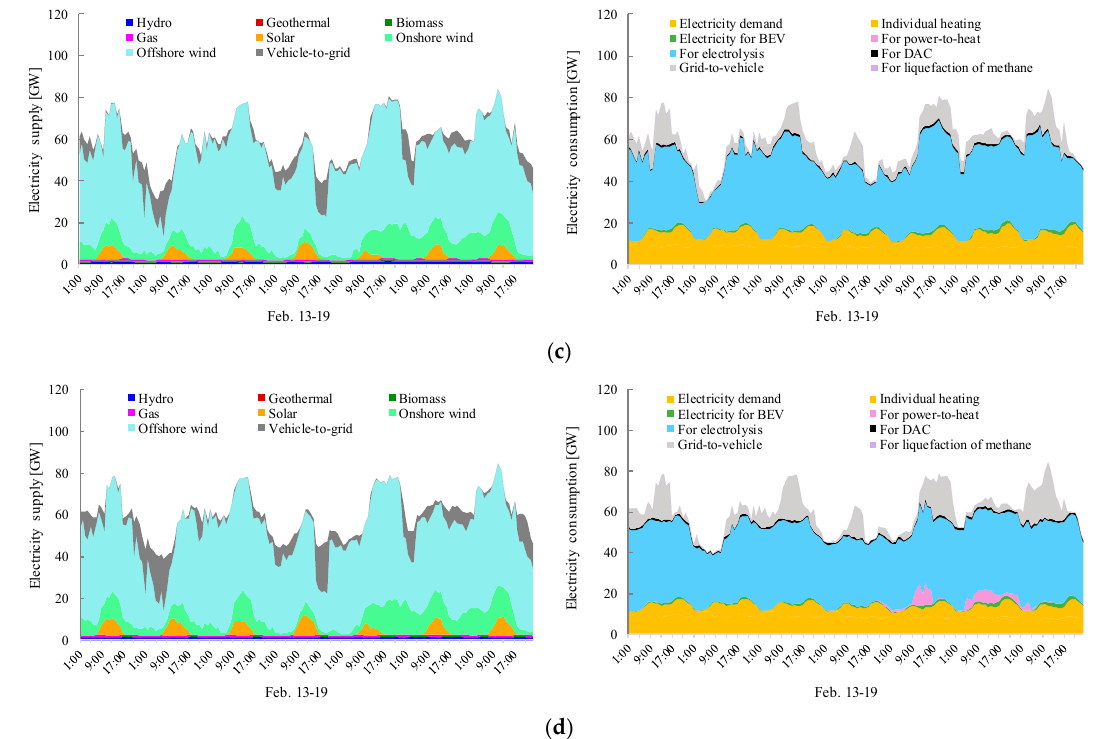
Figure 6. Hourly electricity balances in ( a ) All-BEV_IND scenario. ( b ) All-BEV_HD120 scenario. ( c ) A-BEV-V2G_IND scenario. ( d ) All-BEV-V2G_HD120 scenario.